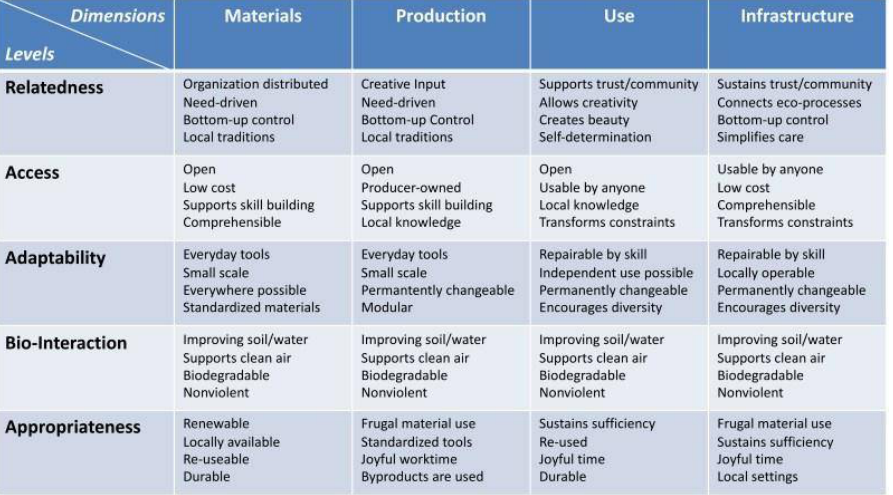
Figure 1. Dimensions and levels of the MCT. Adapted by: https://www.andrereichel.de/2019/05/20/artificial-intelligence-convivial-technology/. Accessed on 6 July